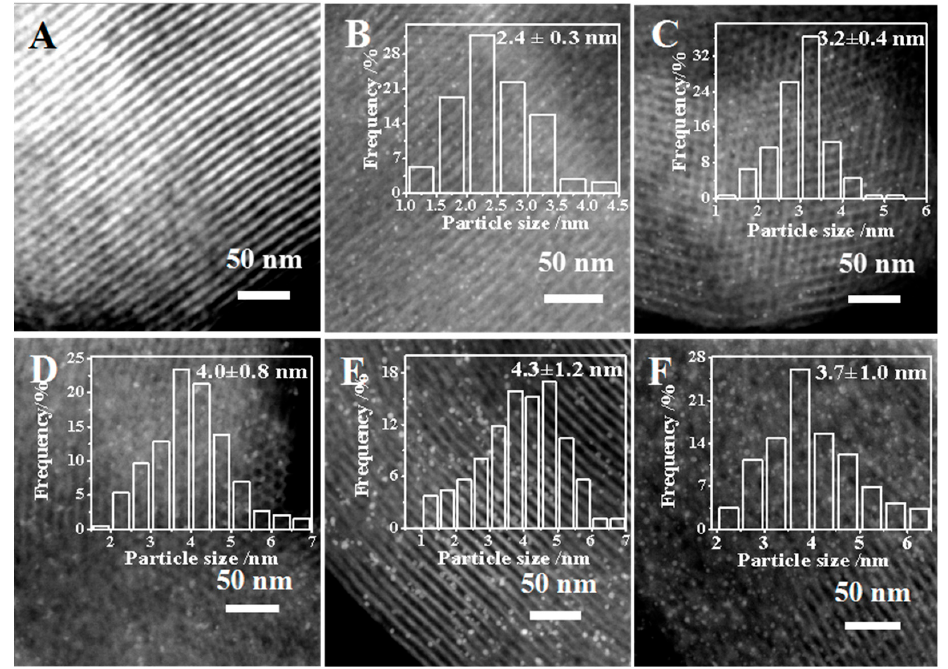
Figure 4. HRTEM images of ( A ) SBA-15, ( B ) 1%Pt-SBA-15 pH = 1, ( C ) 1%Pt-SBA-15 pH = 2, ( D ) 1%Pt-SBA-15 pH = 6A, ( E ) 1%Pt-SBA-15 pH = 6B and ( F ) 1%Pt-SBA-15 pH = 6C. The insets in images ( B – F ) are the histograms of the Pt NP frequency distributions.